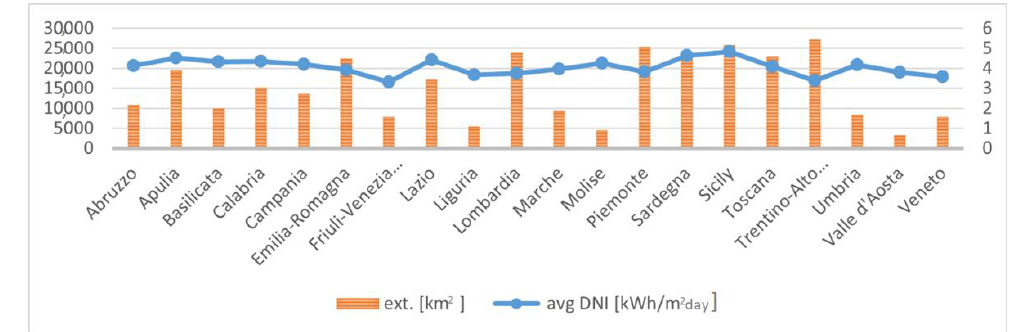
Figure 3. Average DNI for Italian regions vs. their extension.